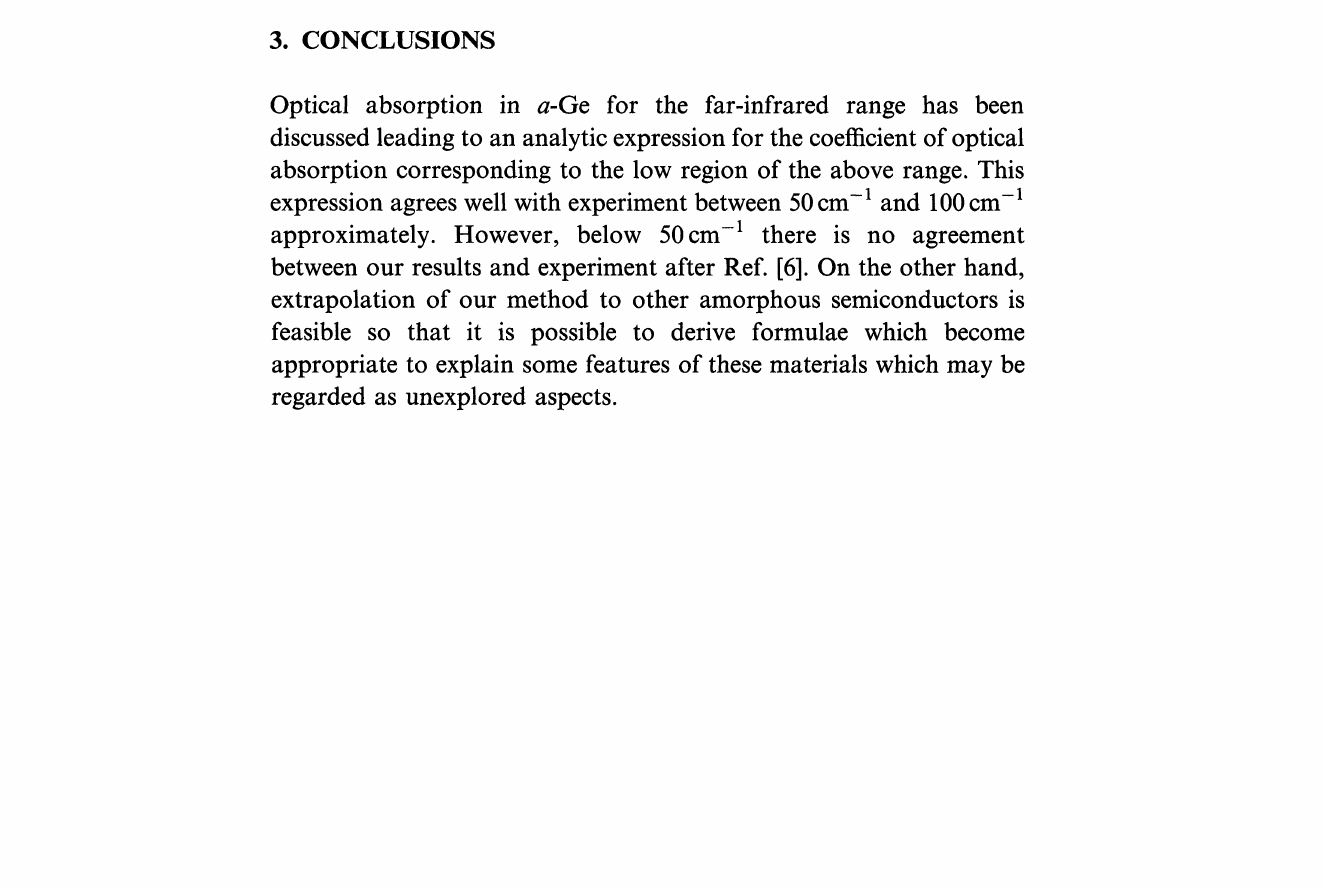
y’nN--1 ]anl26(w- (-on) N-1 "n=l ]an126( w Odn) lim a kw lim N----cx N--cxz N- (N- 1) kw lim [laN125(w